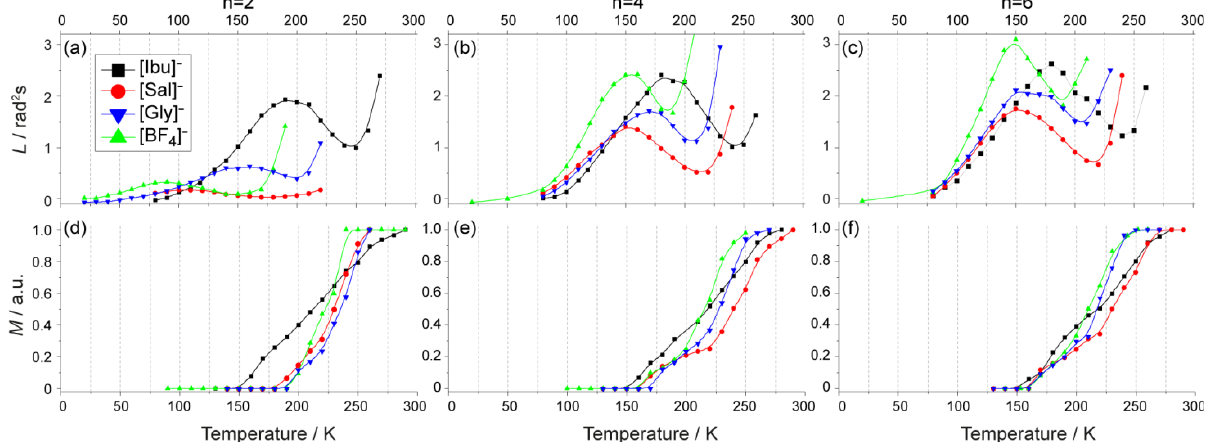
Figure 2. ( a – c ) The temperature dependence of the motional parameter, L ≈ 10 11 <α 2 >τ c , for nitroxide radical, N1; ( d – f ) the mobile fraction, M, for the nitroxide radical, TEMPO-D 18 , dissolved in selected API-ILs. The graphs are grouped by the same n in the cation alkyl chain. The T g values are given in the text or the SI. Solid lines guide the eye. The error of each M value does not exceed ~30%.